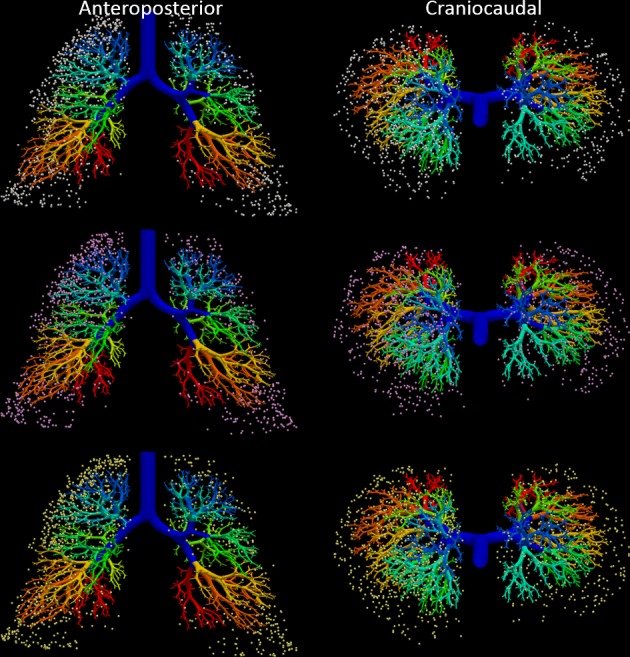
Simulated airway model at expiration showing 2mm lesions as spheres distributed randomly throughout the lung.The different colored lesions represent the 3 repeated models (white = model 1; pink = model 2; yellow = model 3). Images were created in ParaView 4.3.1.